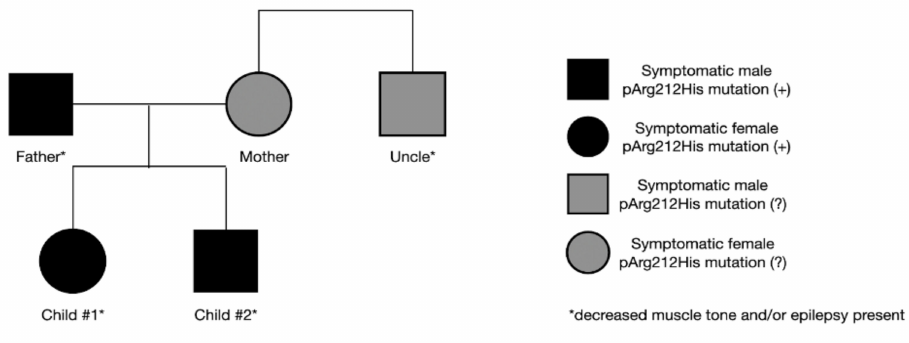
Figure 3. Symptoms and the presence of genetic mutation in the